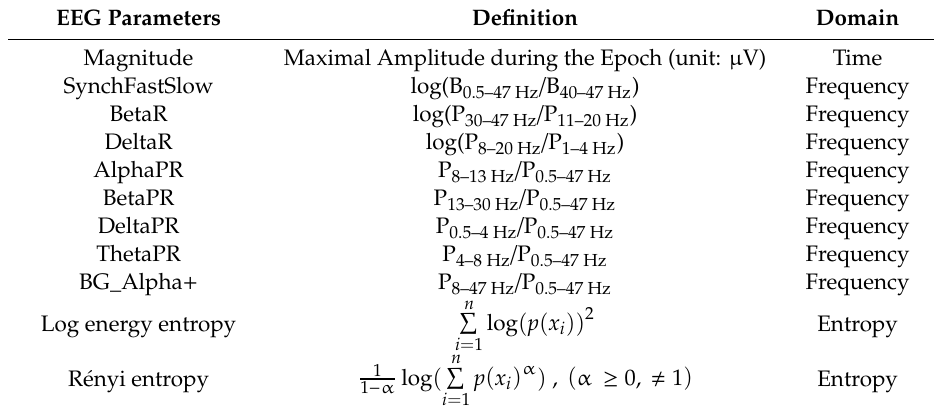
Table 1. EEG parameters considered in this